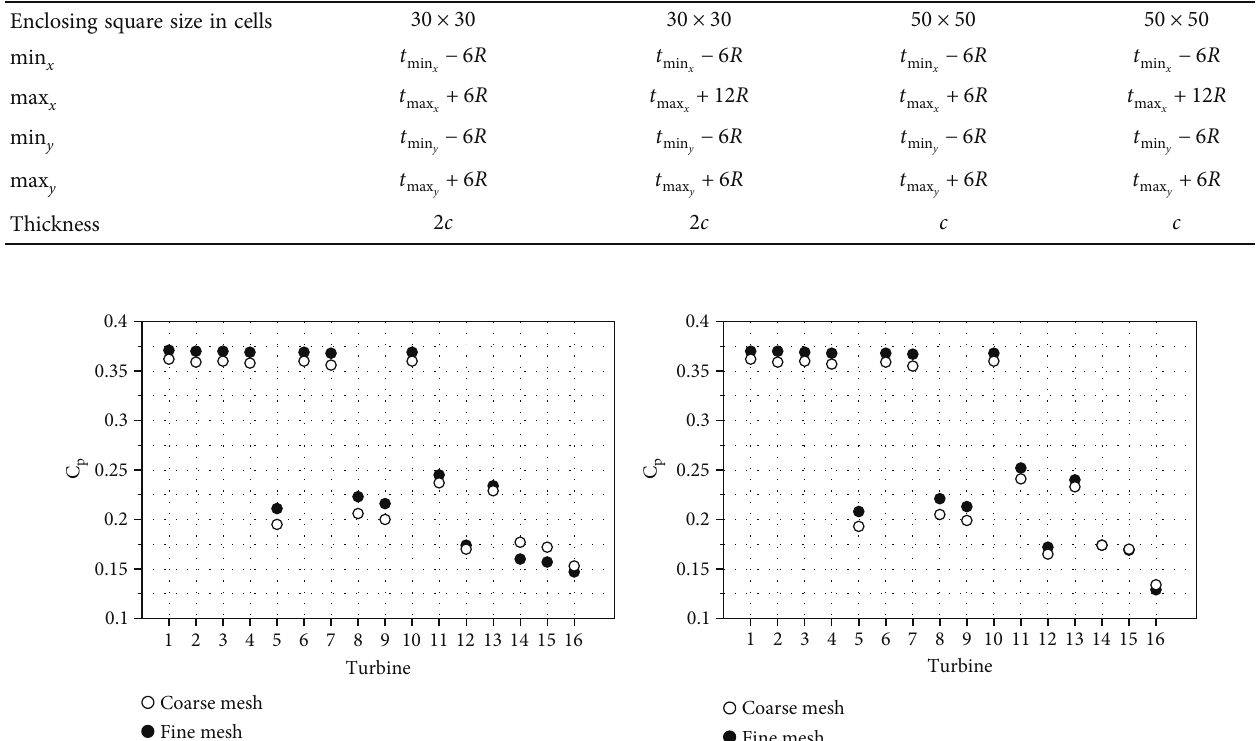
Figure 4: Two di ff erent meshes used for sensitivity analysis.